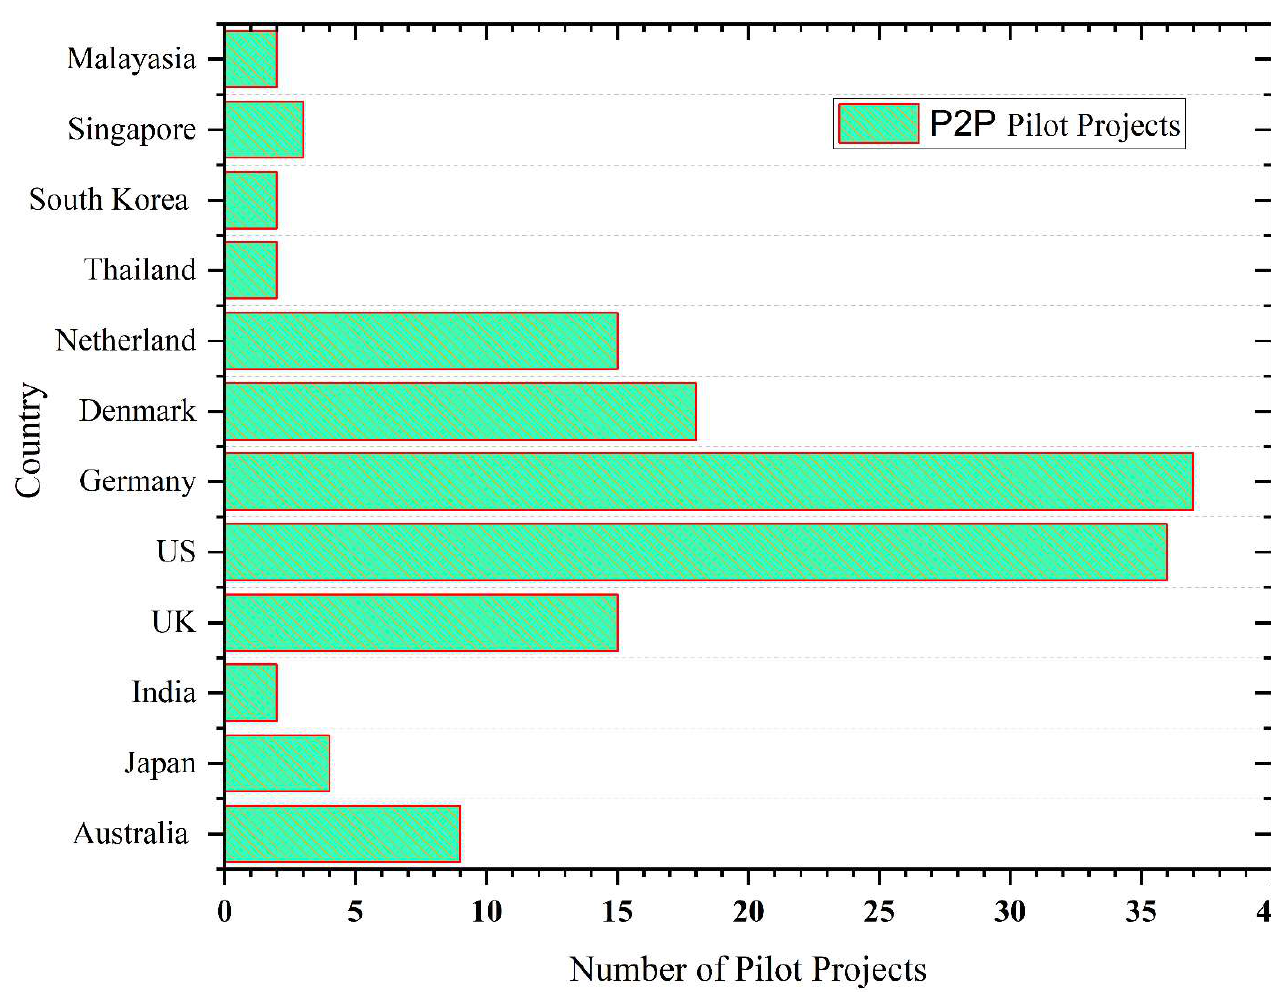
Figure 3. The number of P2P energy trading pilot projects that were implemented by several countries by December 2022. Reprinted with permission from [22]. Copyright 2022, Elsevier. Table 1. Summary of related review papers related to